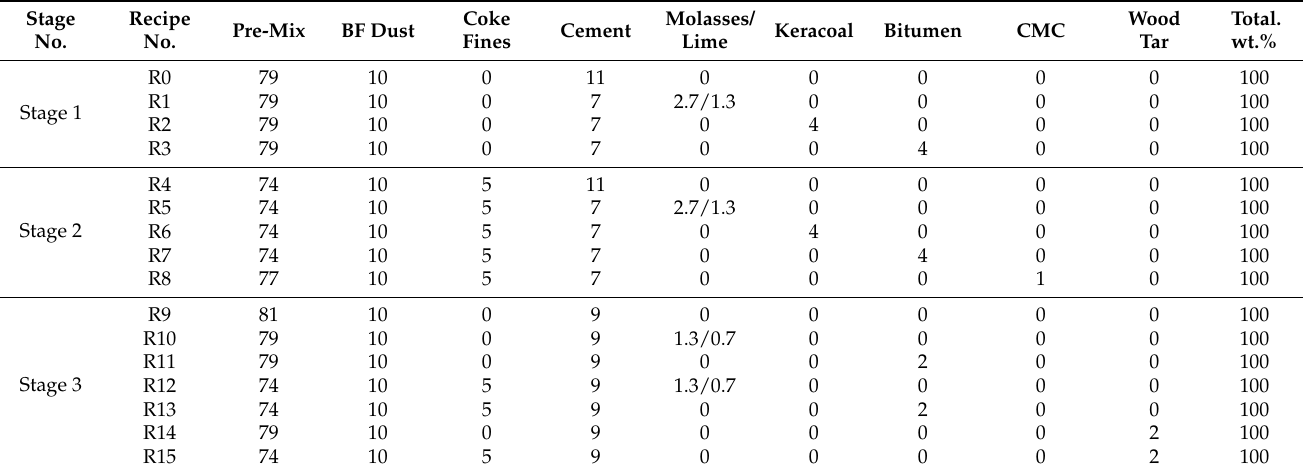
Table 3. Design and expected benefits of BF